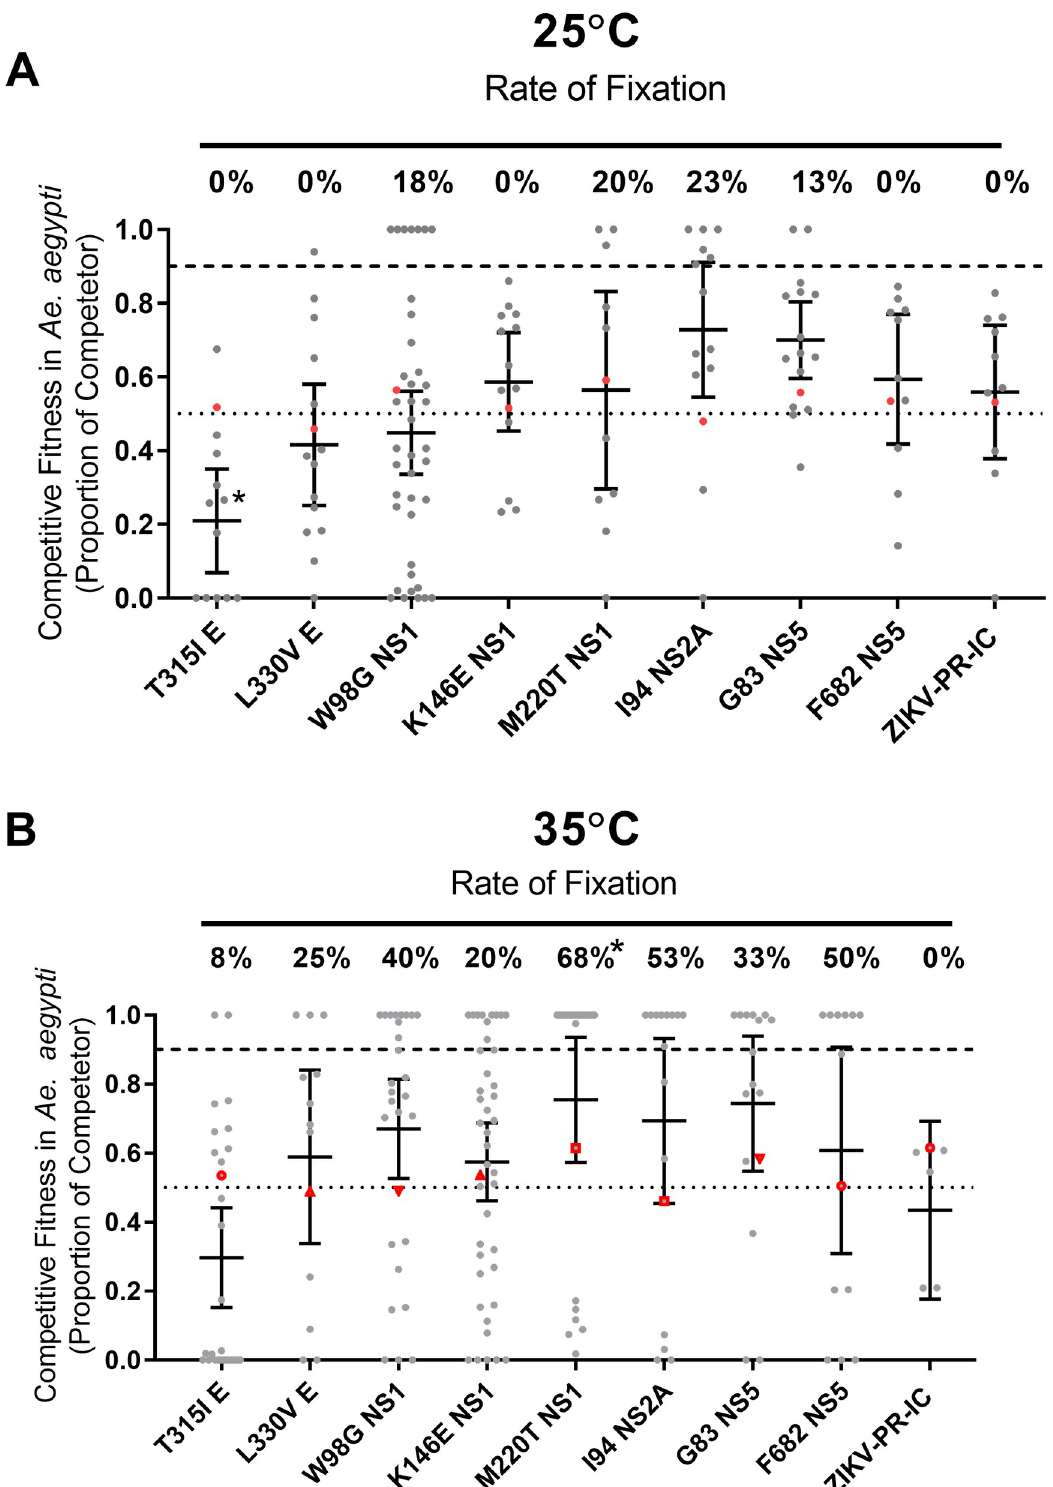
Fig 5. High extrinsic incubation temperature increases variant fixation in Aedes aegypti. Indicated mutations were engineered into a ZIKV-PR-IC and mixed with a ZIKV-REF virus. The proportion of each competitor (grey, mean with 95% CI, � p- value < 0.05 compared with ZIKV-PR-IC, Kruskal-Wallis and Dunn’s) and rate of fixation ( � p-value < 0.05 compared with